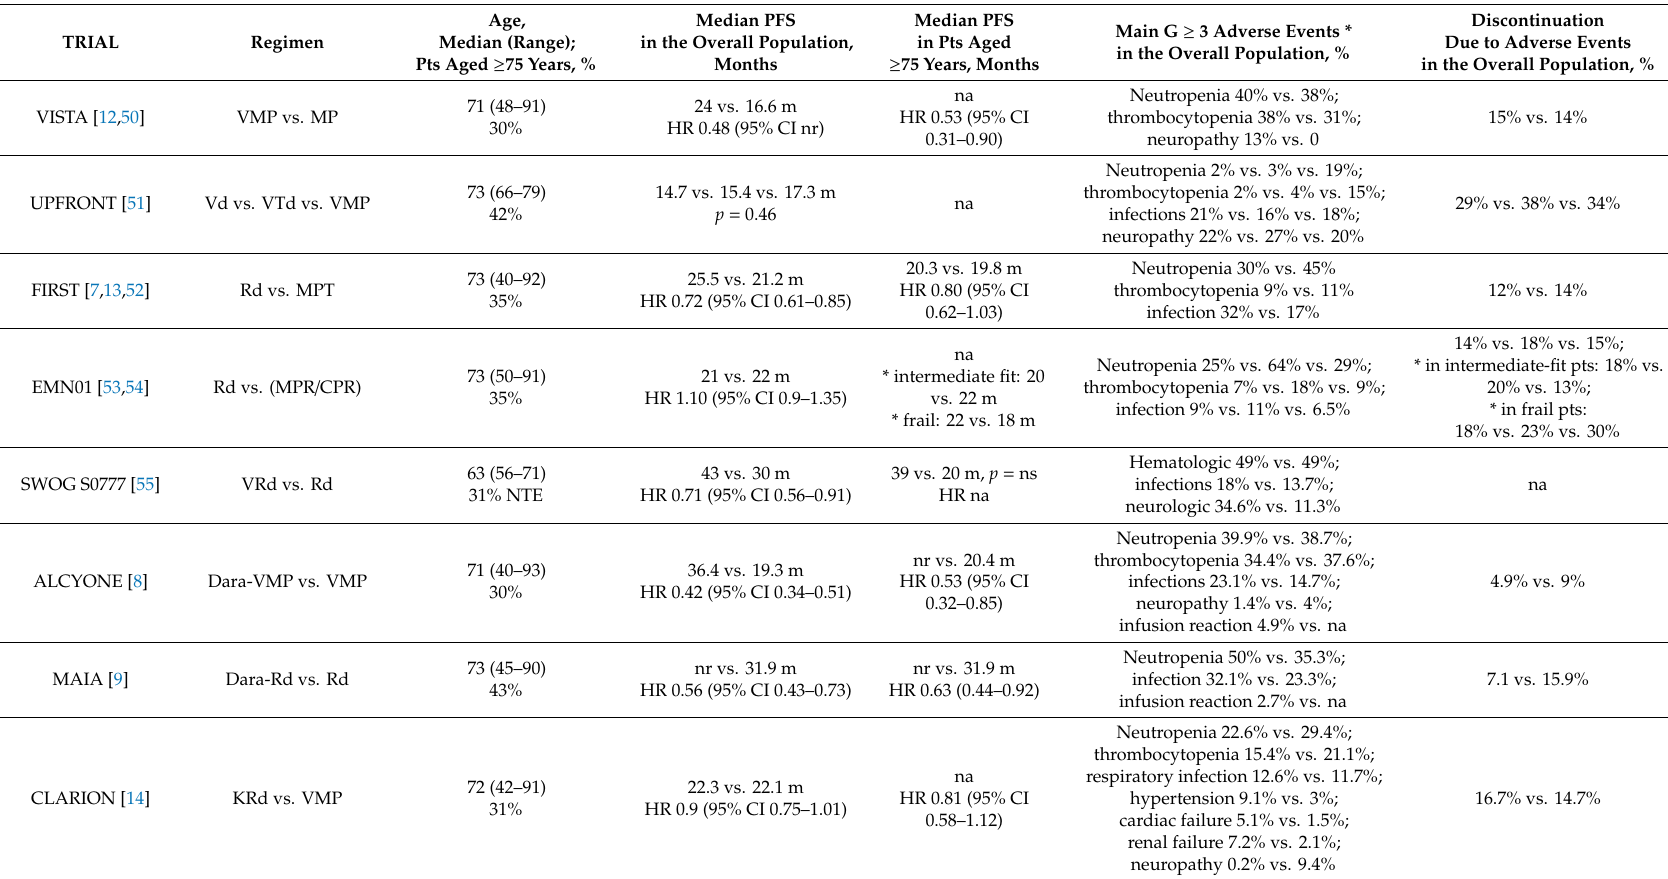
Table 1. Treatment outcome in ≥ 75-year-old patients enrolled in phase III clinical trials at